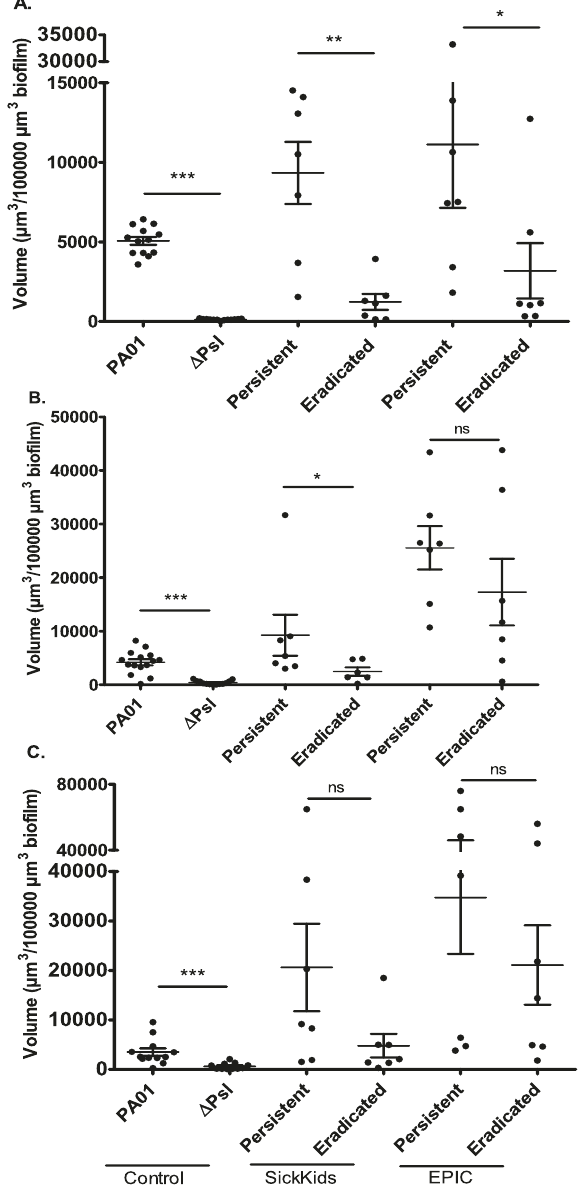
Fig. 3 Anti-Psl antibody binding. SickKids P. aeruginosa isolates ( N = 7 Persistent; N = 7 eradicated), EPIC P. aeruginosa isolates ( N = 7 Persistent; N = 7 eradicated), laboratory P. aeruginosa strain PAO1 and Δ psl (Psl de fi cient PAO1) were grown as bio fi lms for 48 h then incubated for 90 min with fl uorescently labeled monoclonal anti-Psl antibodies, A Psl0096, B WapR001, and C WapR016. The mean antibody fl uorescence volume (µm 3 /100,000 µm 3 bio fi lm) for each isolate (done in triplicate) was calculated and the mean of all isolates was plotted with standard error of the mean (SEM). Statistics were performed using non-parametric Mann – Whitney test *** p < 0.001, ** p < 0.01, * p < 0.05, ns not signi fi